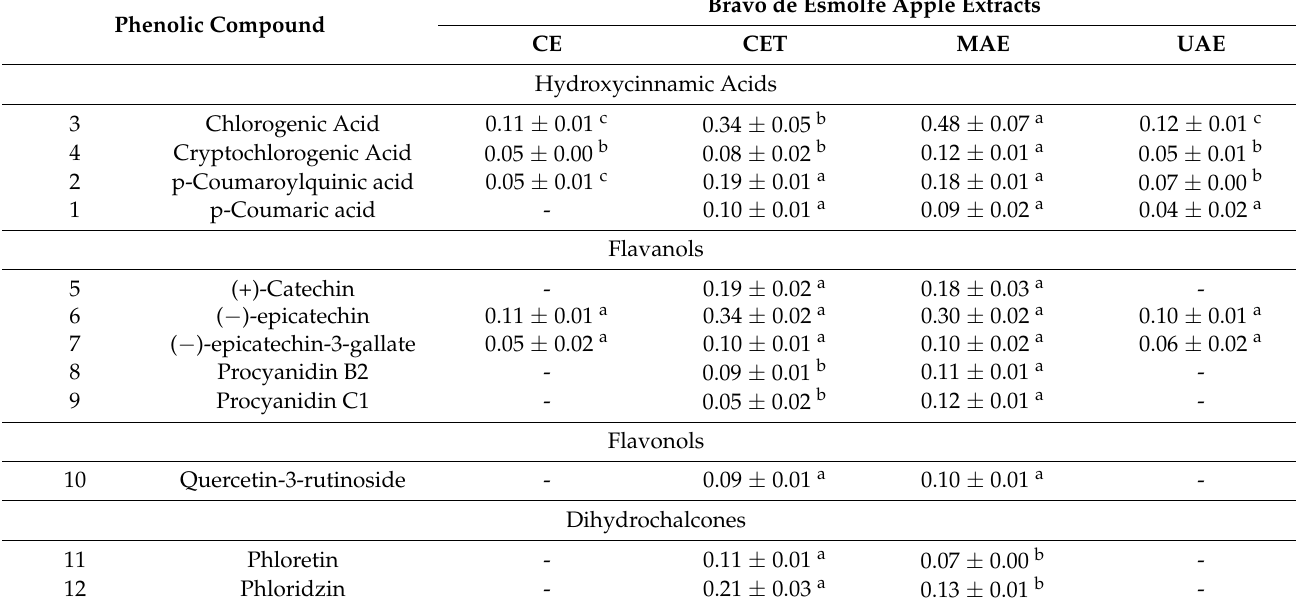
Table 3. Quantification of main phenolic compounds (mg/g DE) in different extracts of BE apples by HPLC-DAD. Values are represented by the average ± standard deviation. Different letters in the row (a, b, c) mean significant differences between extraction techniques, determined by Tukey’s test ( p <